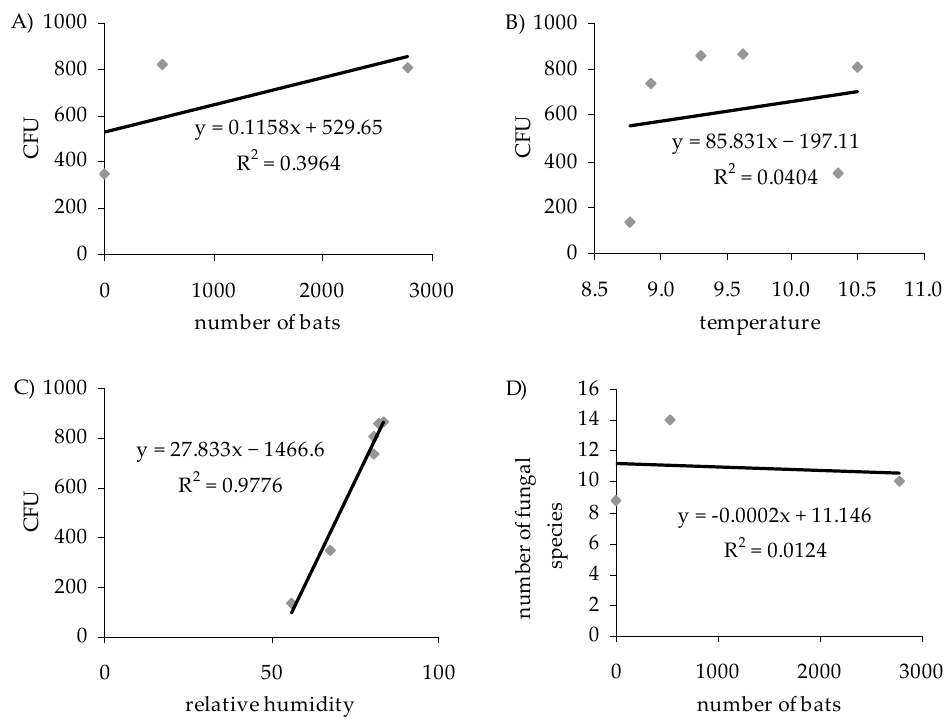
Figure 5. Relationships between ( A ) the number of bats and airborne fungal spores (CFU m − 3 of air), ( B ) the number of airborne fungal spores (CFU m − 3 of air) and temperature ( ◦ C), ( C ) the number of airborne fungal spores (CFU m − 3 of air) and relative humidity (%), and ( D ) the number of bats and airborne fungal species in the underground hibernation sites of the Nietoperek bat reserve. Study site number I was outside the underground object and locations from II to VI inside it. An air sampler was positioned 1.5 m above the level of the floor in the study sites from I to III, and it was positioned at a distance of 0.7 to 1 m from the clusters of M. myotis in the locations from IV to VI.